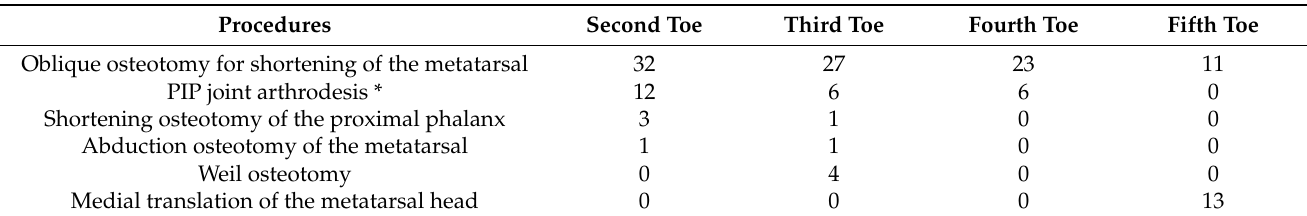
Table 1. Procedures for correcting lesser toe deformities.